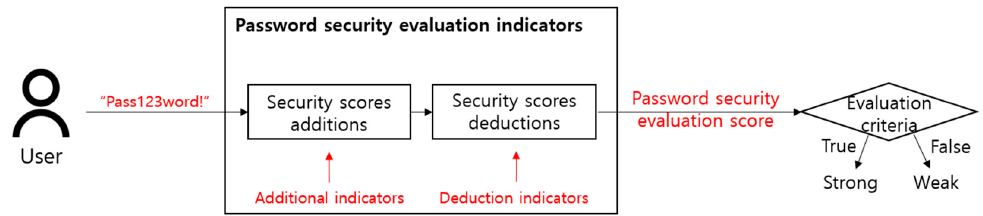
Figure 2. Existing password security evaluation process.